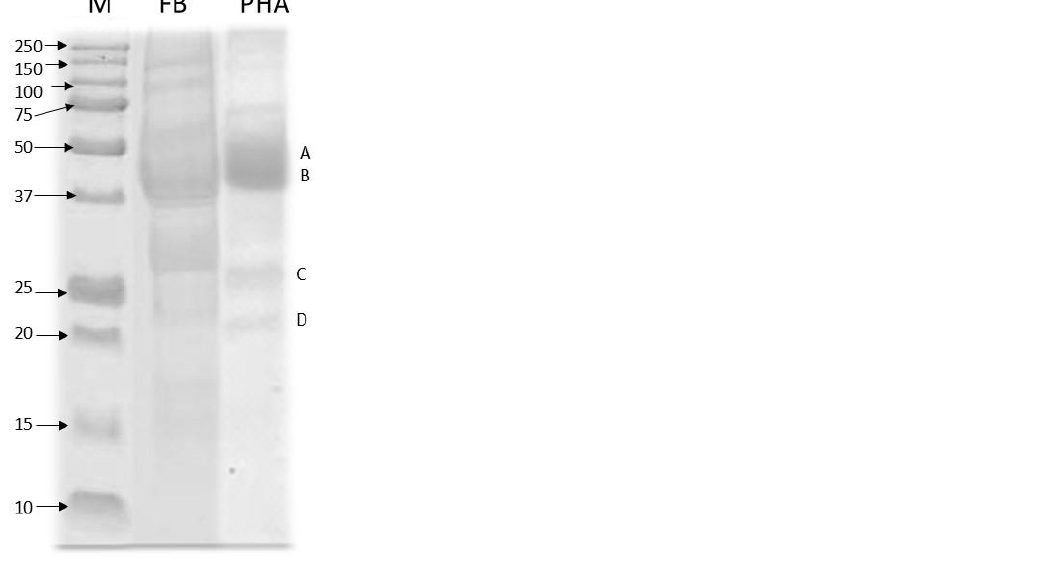
Figure 1. Electrophoretic (SDS–PAGE) pattern of P. vulgaris flour (FB) and phaseolin (PHA). Lane M = MW standards (kDa); Lane FB = bean flour; Lane P = phaseolin extract. Protein bands: ( A ): Phaseolin (43–47 kDa); ( B ): PHA-E, PHA-L (31 kDa); ( C ): Phaseolin b type (fragment, 25 kDa); ( D ): Phaseolin a type (fragment, 21 kDa).